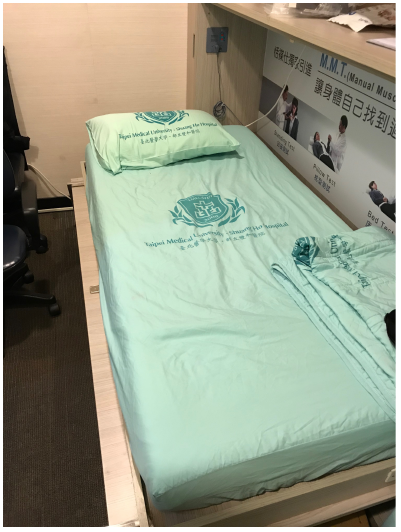
Figure 1. Sleep monitoring room in the sleep center. The patients suffer from sleep disease are closely monitored in this room during sleep.